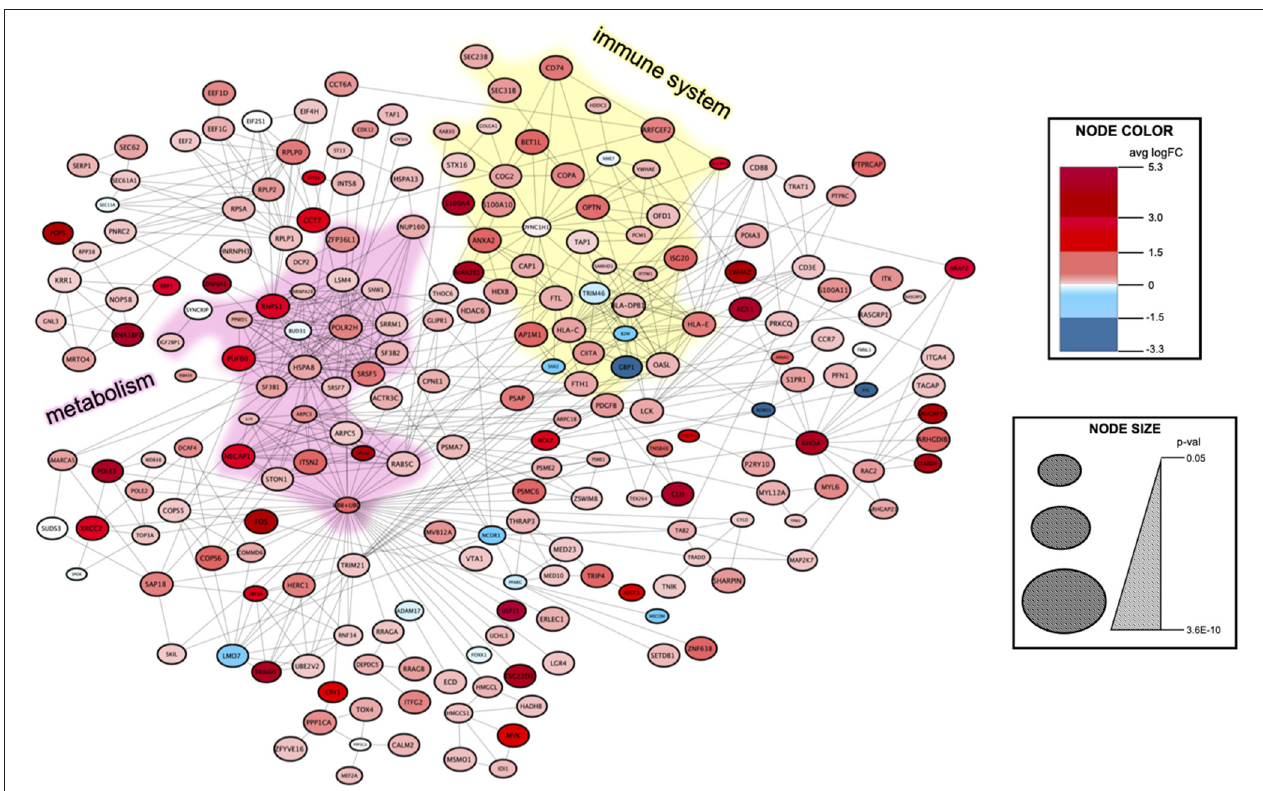
FIGURE 4 | Protein–protein interaction network to identify the signal transduction pathways of interest in the aneurysm EC subpopulation. The DEGs between the aneurysm subpopulation and the remaining cells were identified using MAST, and then, fed into the STRING database (see Supplementary Methods ). The resulting network contains 219 nodes with 630 edges. Clustering using the MCODE algorithm detects highly interconnected regions of the network. An immune system subnetwork is highlighted in yellow color and a metabolism subnetwork is highlighted in pink color ( Supplementary Figure 7 ). Node color represents an average logarithmic fold change and node size corresponds to p -value (see legend at